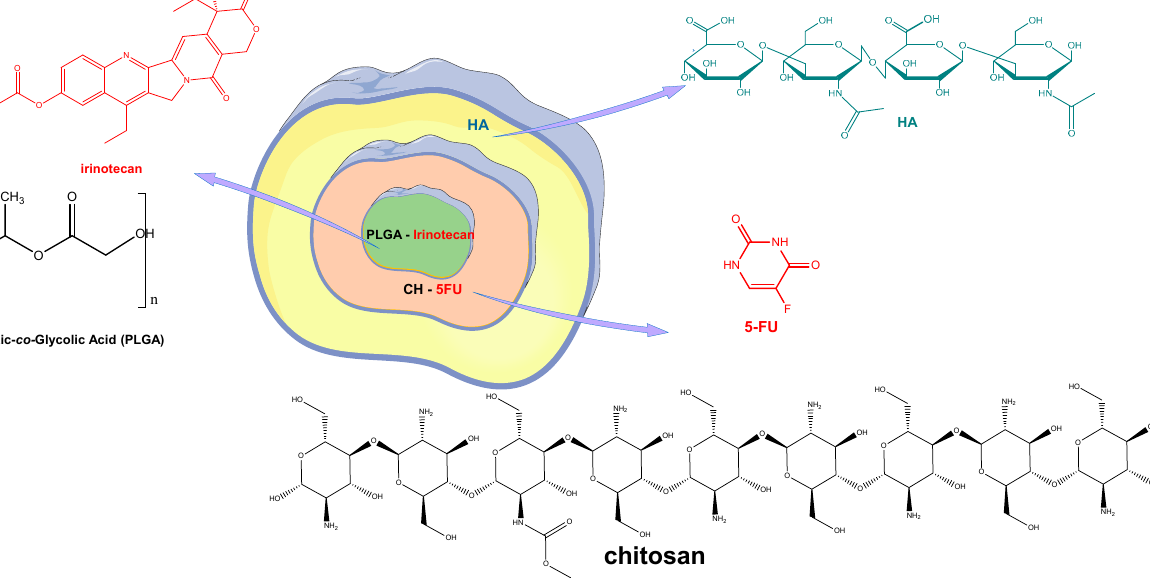
Figure 7. Irinotecan and 5-FU co-loaded nanoparticles [135]. 5-FU—5 fluorouracil; HA—hyaluronic acid; PLGA—poly( D,L -lactide- co -glycolide).